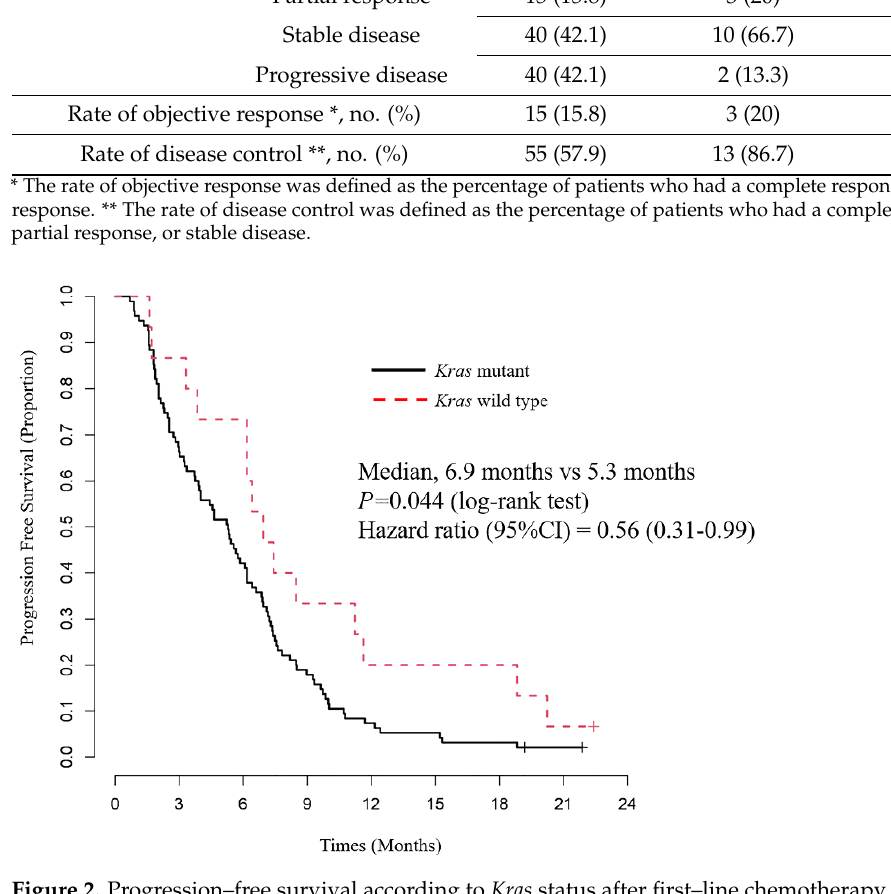
Figure 2. Progression–free survival according to Kras status after first–line chemotherapy with GEM and nab–PTX. The median PFS in the wild-type Kras and mutant Kras groups was 6.9 and 5.3 months, respectively. PFS in the wild-type Kras group was significantly longer than that in the mutant Kras group ( p = 0.044).